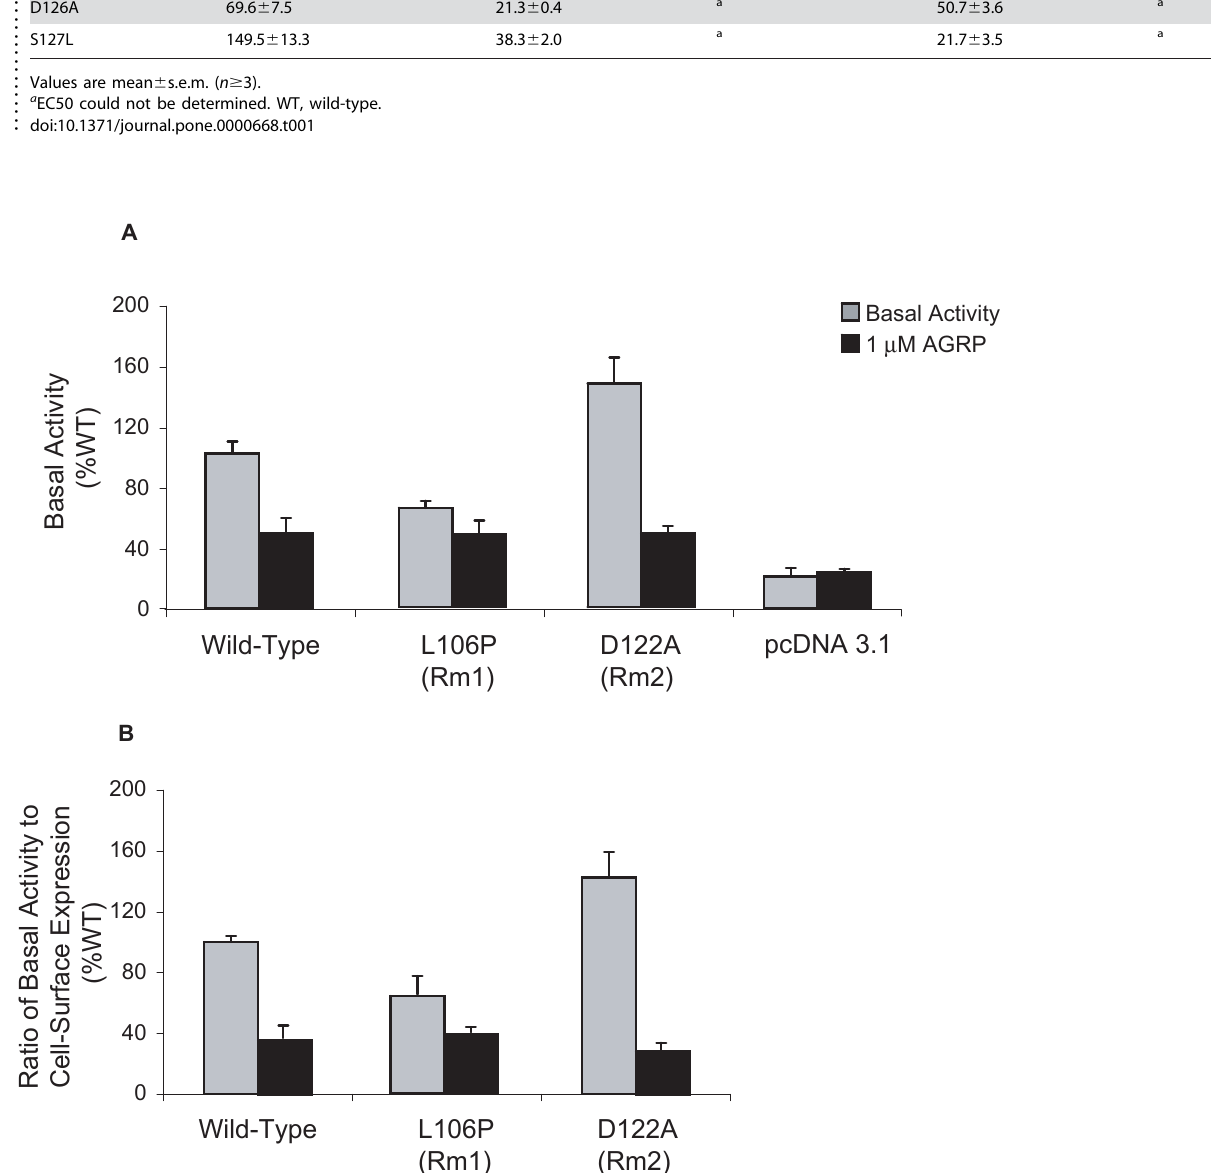
Figure 4. A , Basal activity of wild-type MC4R, Rm1 (L106P), Rm2 (D122A), and mock-transfected cells were measured by detecting basal cAMP release and cAMP release in response to AGRP. B, Ratios of cAMP accumulation to cell-surface expression for wild-type MC4R, Rm1, and Rm2 were determined in the same batch of transiently transfected cells. Values are means 6 s.e.m. of three independent experiments, each performed in quadruplicate. doi:10.1371/journal.pone.0000668.g004 PLoS ONE |